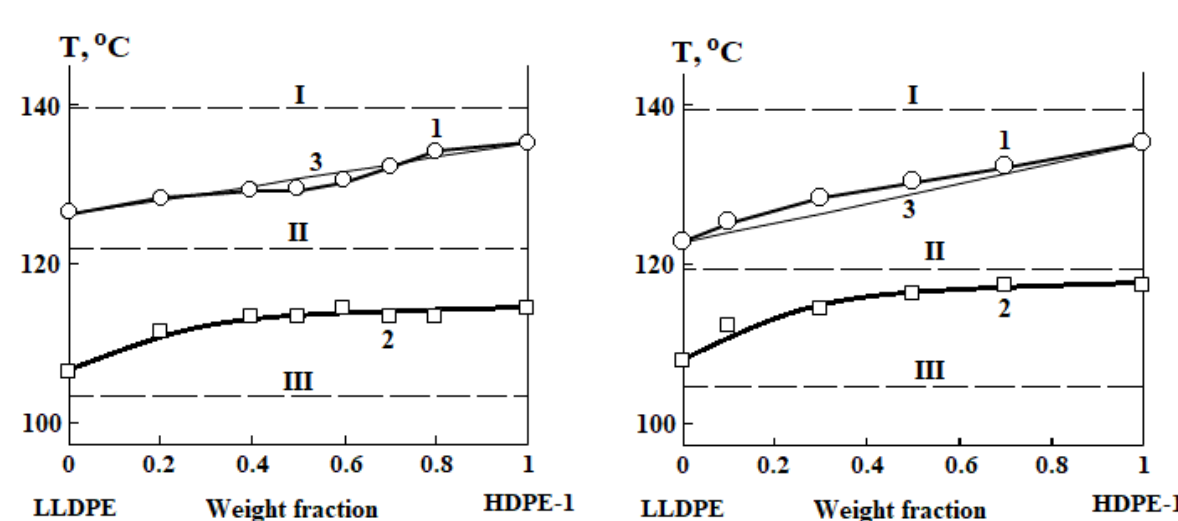
Figure 2. ( a ) Effect of LLDPE content on melting heat and crystallization heat. ( b ) Effect of LLDPE content on crystallinity and co-monomer content (butene-1 and hexene-1) in the macromolecule structure of HDPE/LLDPE binary mixtures.